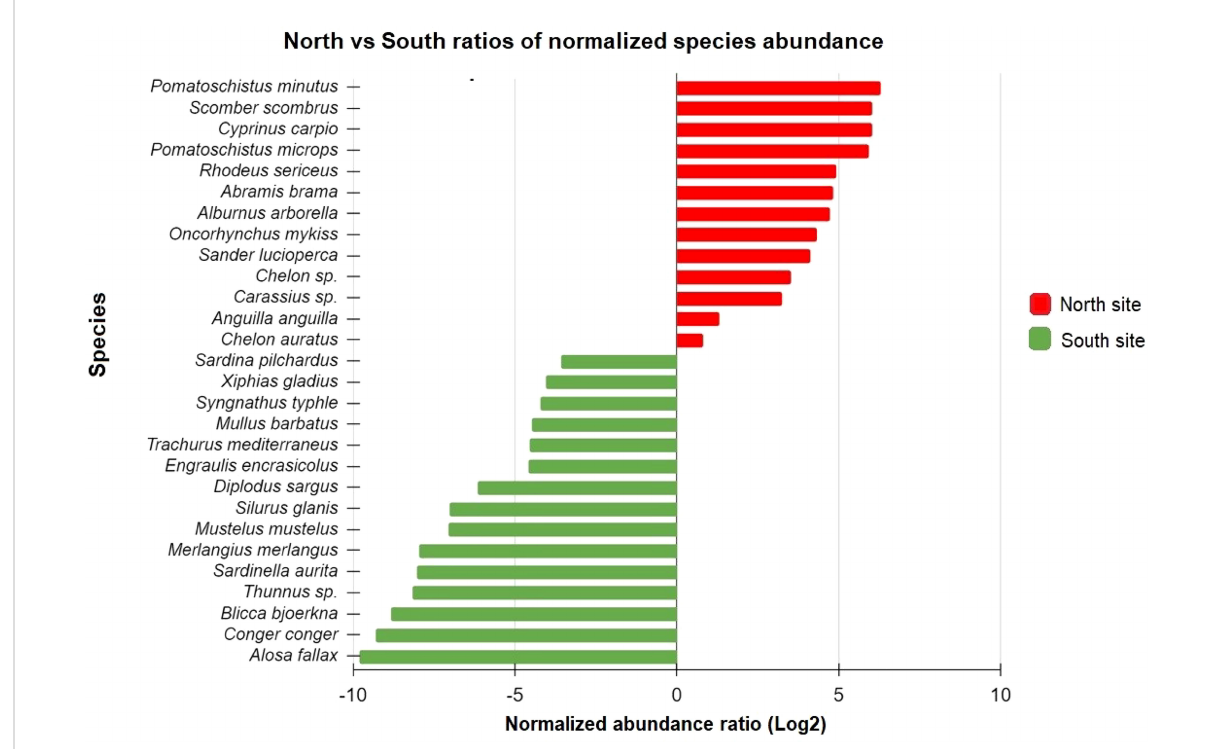
FIGURE 4 Overrepresented species at the North and South sites. On the x-axis, the ratio between North and South normalized abundances is reported in Log2 scale; positive values indicate species overrepresented in the northern site, negative values indicate species overrepresented in the southern site. Only species both present in north and south sites have been considered in this graph and reported on the